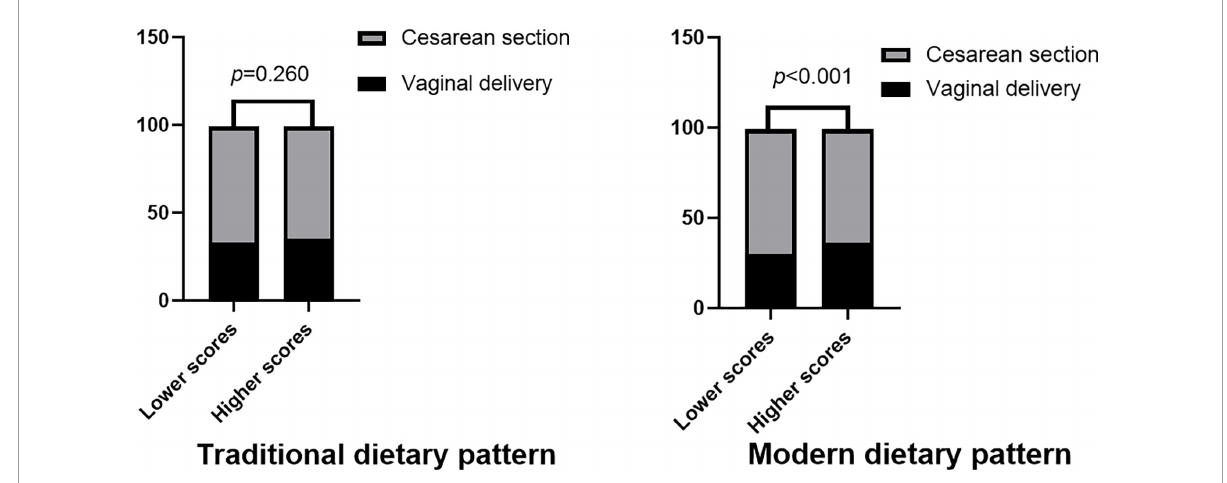
FIGURE2 Associations between modes of delivery and postpartum dietary